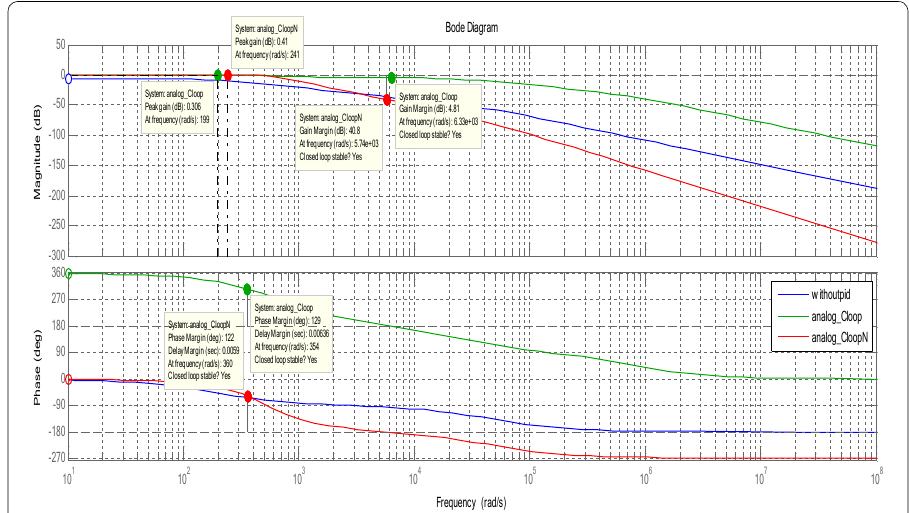
Fig. 13 Analog domain frequency response of BBC with PID and PIDN and without PID control in buck